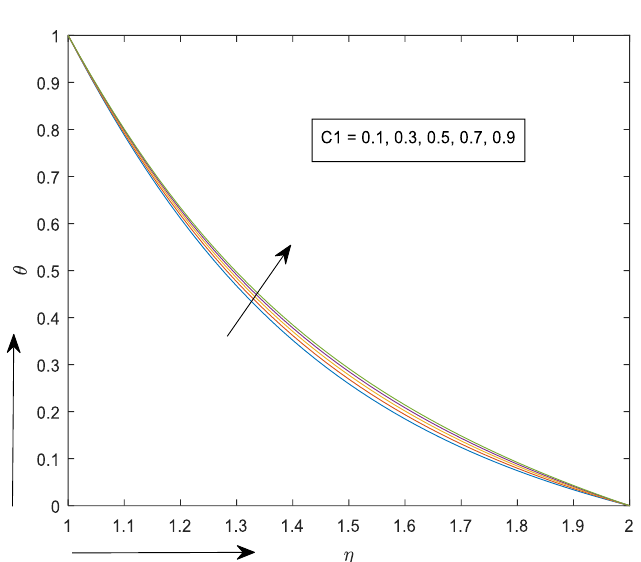
Figure 6. Temperature profile for different values of 𝐶